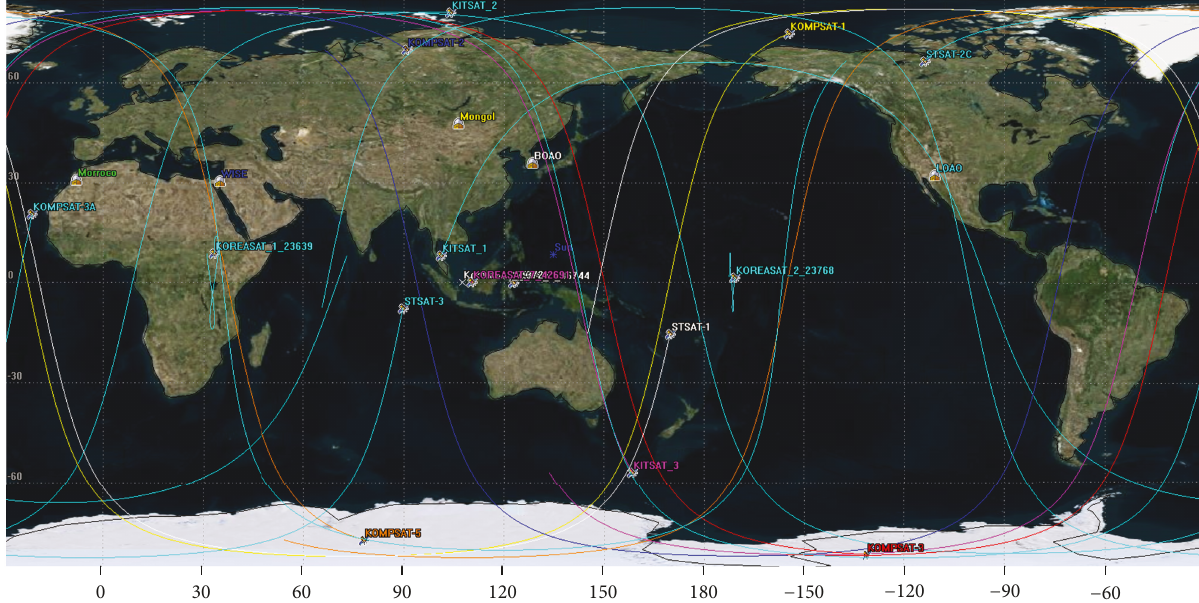
Figure 1: OWL-Net site locations and observation target, 11 LEO satellites and 6 GEO satellites (4 GEOs are located near 128 E of longitude; Koreasat_1 and 2 are drifting